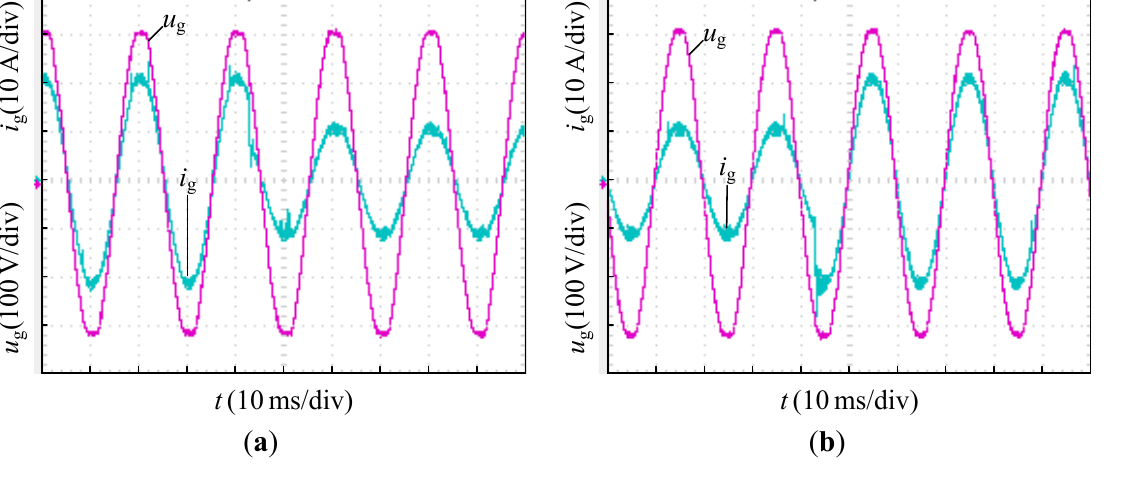
, voltage stress of the 9